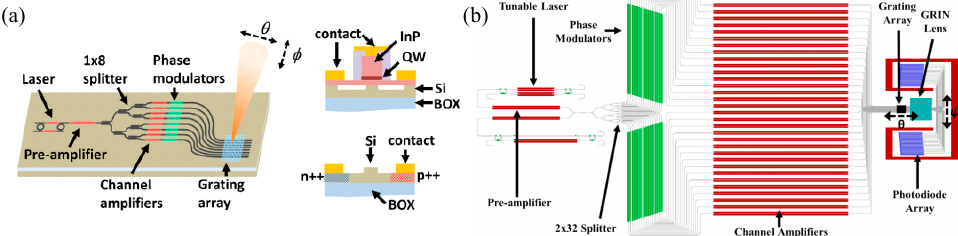
Figure 5. OPAs with on-chip laser sources based on the hybrid III–V/Si platform. ( a ) Schematics of an OPA with an on-chip laser on the hybrid III–V/Si platform. Reprinted with permission from [81] © The Optical Society. ( b ) The layout of a fully integrated OPA. Reprinted with permission from [82] © The Optical Society.